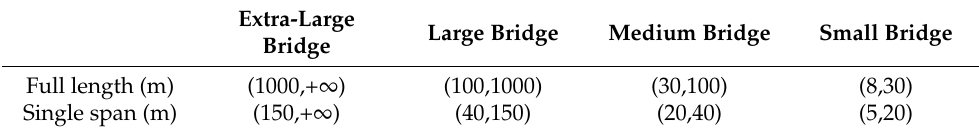
Table 3. Indicators classification of bridge grade